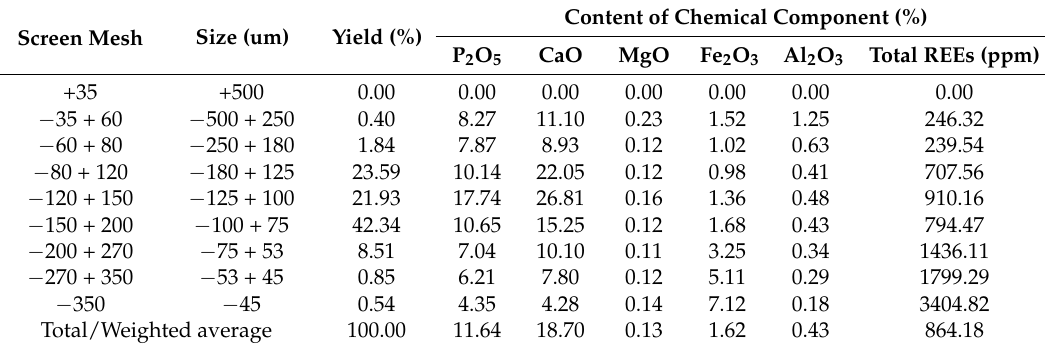
Table 3. Particle-size distribution of the shaking table